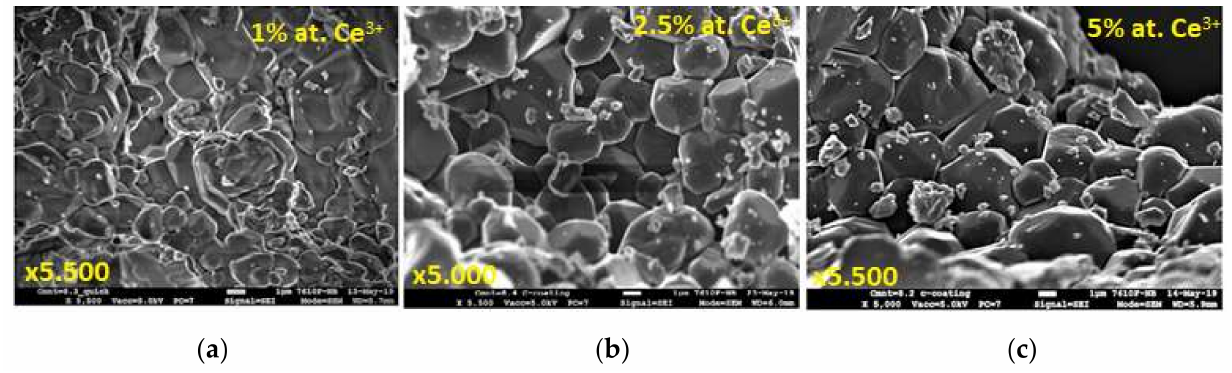
Figure 2. SEM images of CYMSSG:Ce MPs samples with different Ce 3+ concentrations, prepared using 2.5 wt.% B 2 O 3 flux agent: ( a ) 1 at.%, ( b ) 2.5 at.%, and ( c ) 5